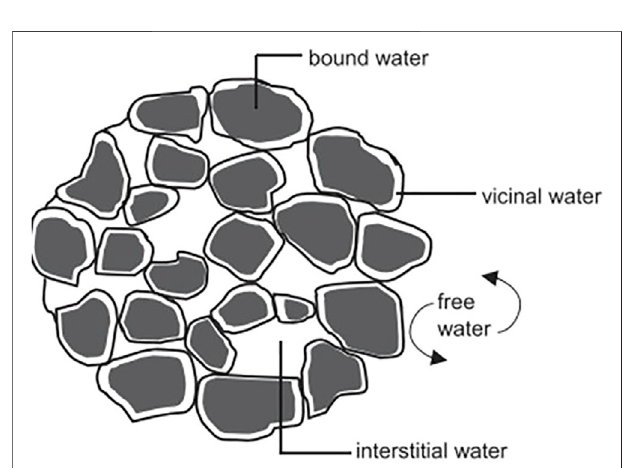
FIGURE 3 | Water distribution in SS according to Vesilind